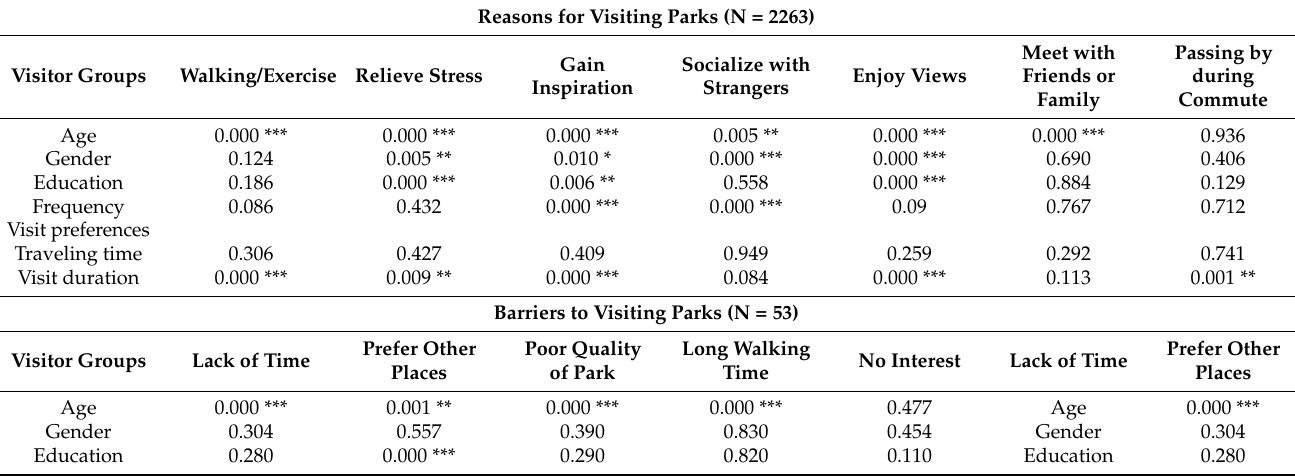
Table 5. Correlating significance values of reasons for and barriers to visiting